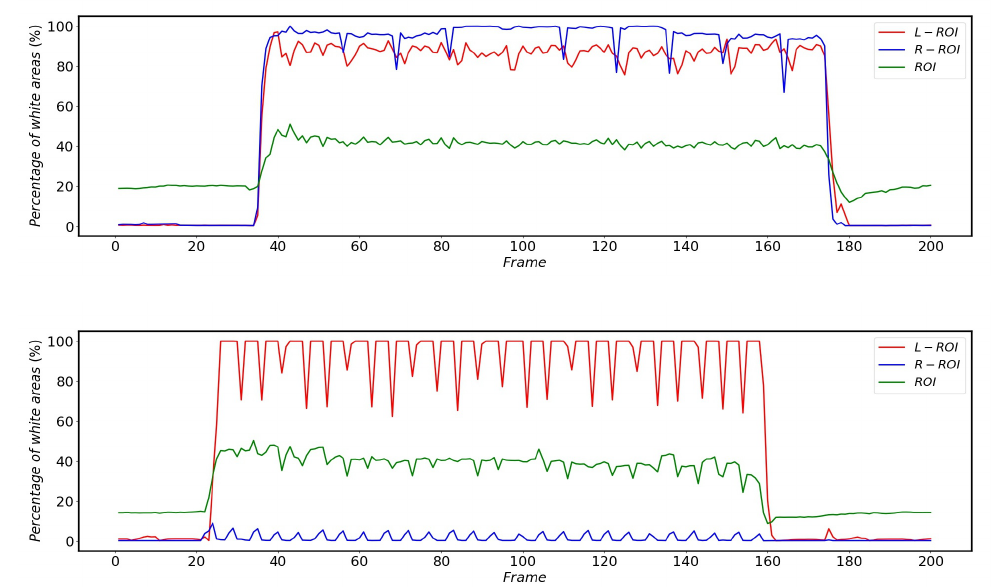
Figure 25. Changes in the percentage of white areas in the vertical projections of different areas of HSR-A ( top ) and HSR-B ( bottom ) during HSR operation after being influenced by the